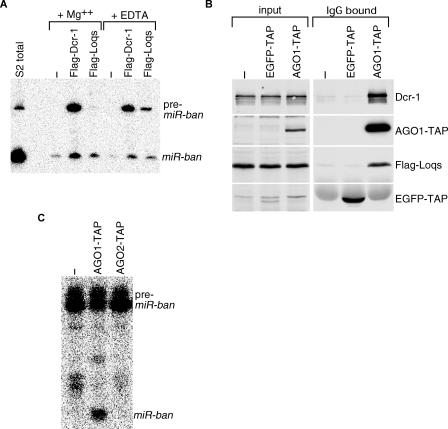
Dicer-1–Loqs Complexes Are Associated with Pre-miRNA and Mature miRNA In Vivo(A) Northern blot analyses show that Flag–Dicer-1 (Flag-Dcr-1) complex contains both pre- and mature form of miR-ban. Notably, the precursor form of miR-ban was accumulated in the Dicer-1 complex. In the case of the Loqs complex, the precursor apparently accumulated within the complex when the Flag–Loqs complex was prepared in the presence of EDTA that was shown to inhibit the pre-miRNA processing activity in Figure 5D.(B) AGO1 associates with Dicer-1 and Loqs. IgG-bound fractions prepared from S2 cells expressing AGO1–TAP, EGFP–TAP, or the parental S2 cells (−), were subjected to Western blotting using antibodies against Dicer-1, AGO1, and Flag (for Loqs). Dicer-1 is not present in AGO2-associated complex.(C) In vitro processing of pre-miR-ban using affinity-purified AGO1 complexes. Purified AGO1–TAP or AGO2–TAP complexes were incubated with pre-miR-ban (precursor) and tested for processing activity. “−” shows the activity of a negative control prepared from parental S2 cells.